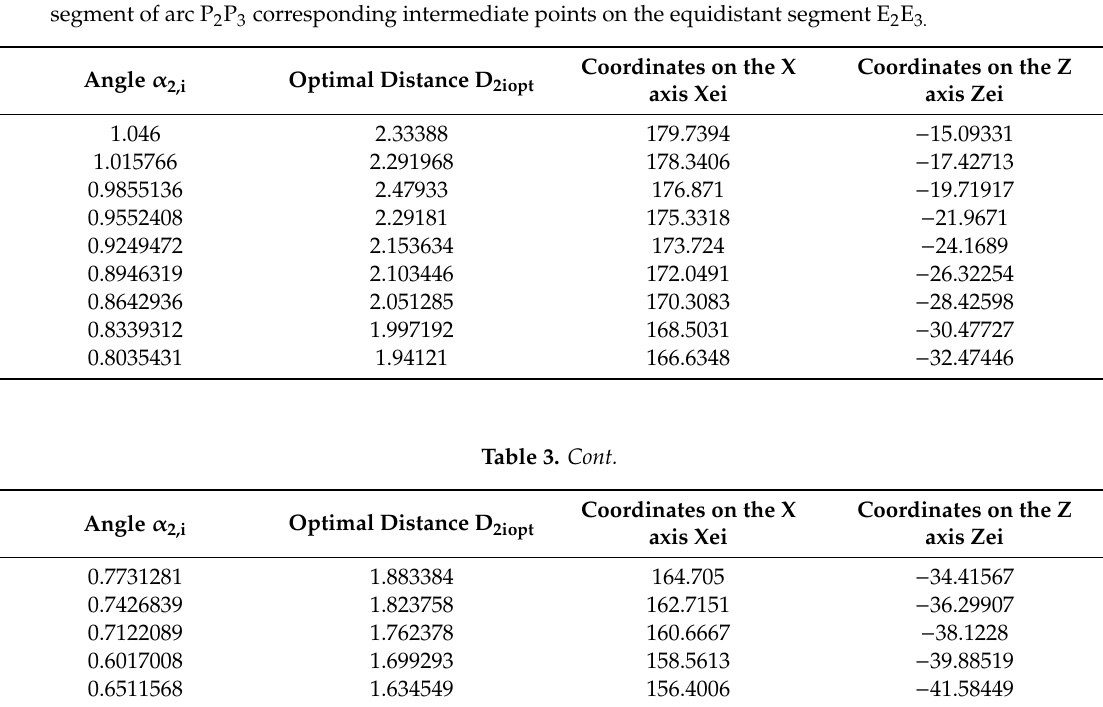
Table 3. The results of the optimization: the optimal position of the processing planes in space for